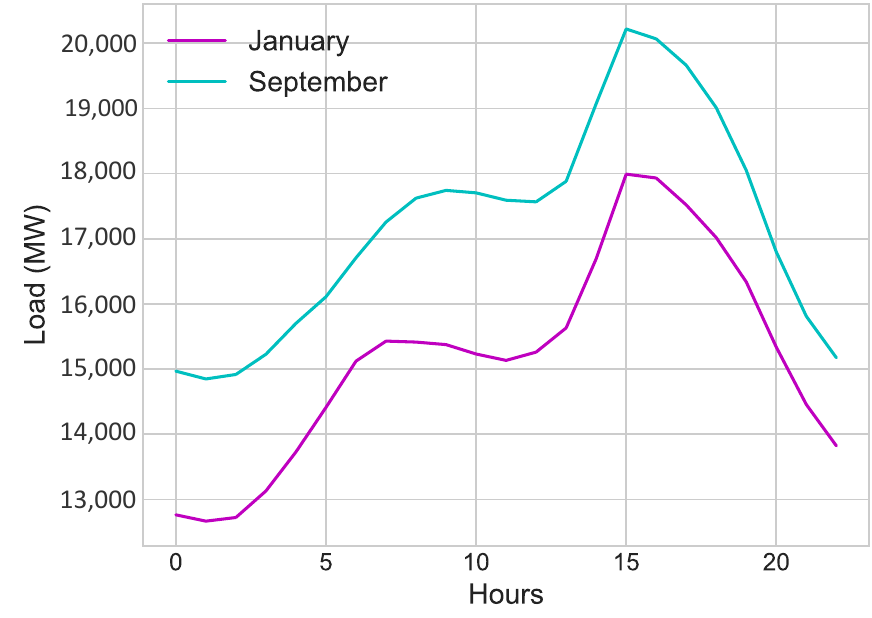
Figure 9. Hourly Load (MW) of January and September 2018.